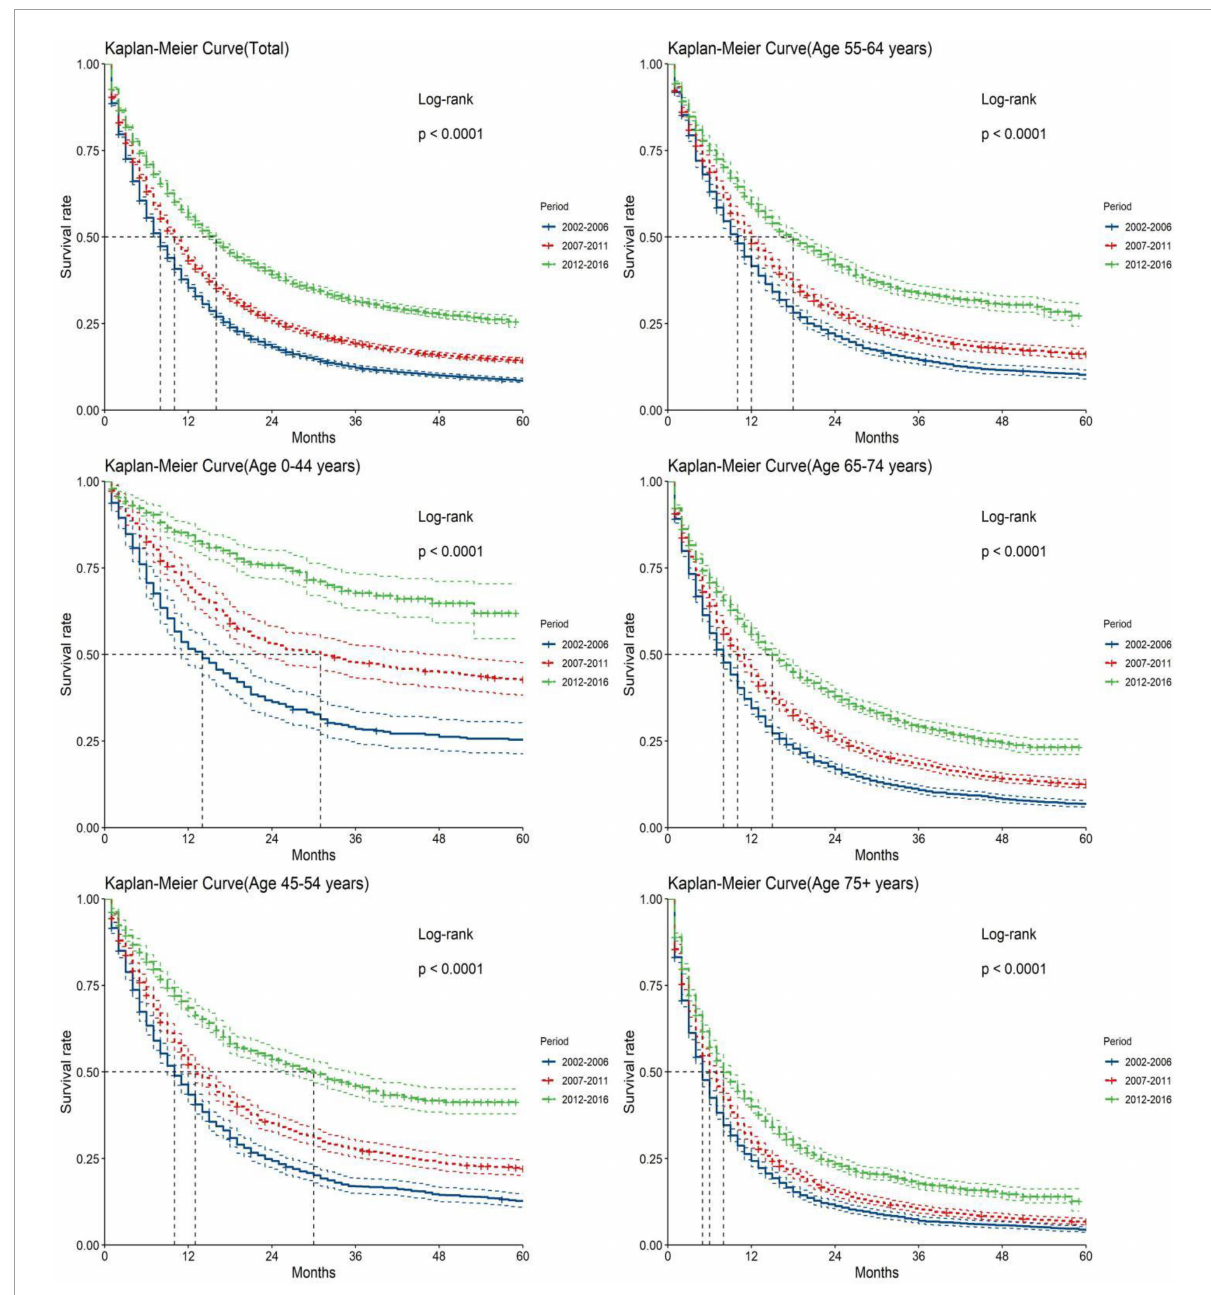
FIGURE3 Kaplan-Meier survival analyses for patients with pancreatic cancer (PC) from 2002 to 2016. Data are shown by age group (total and age 0–44, 45–54, 55–64, 65–74, and 75+ years) and calendar